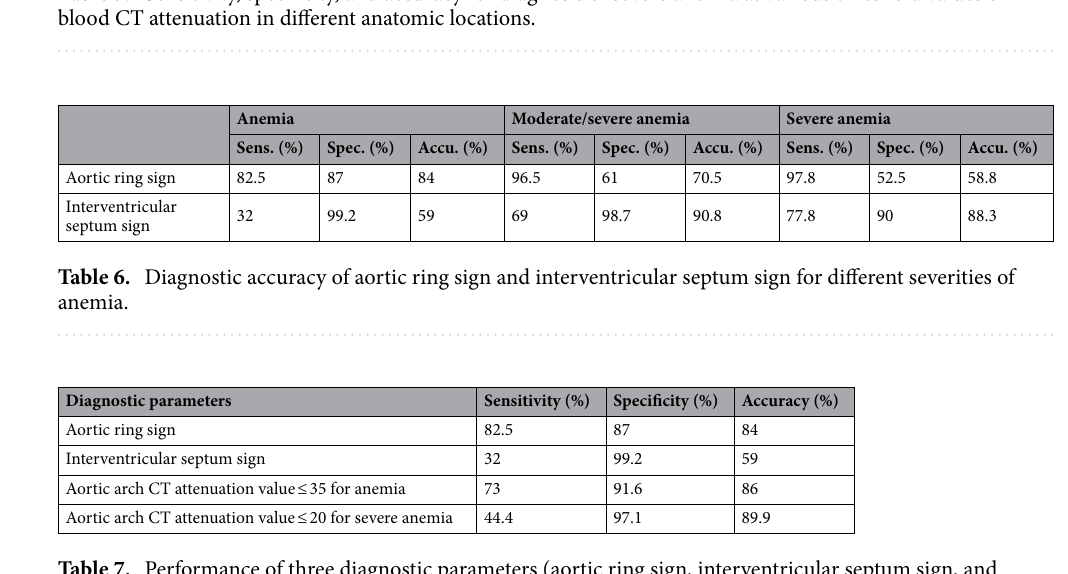
Table 7. Performance of three diagnostic parameters (aortic ring sign, interventricular septum sign, and aortic arch CT attenuation value) in diagnosing anemia.